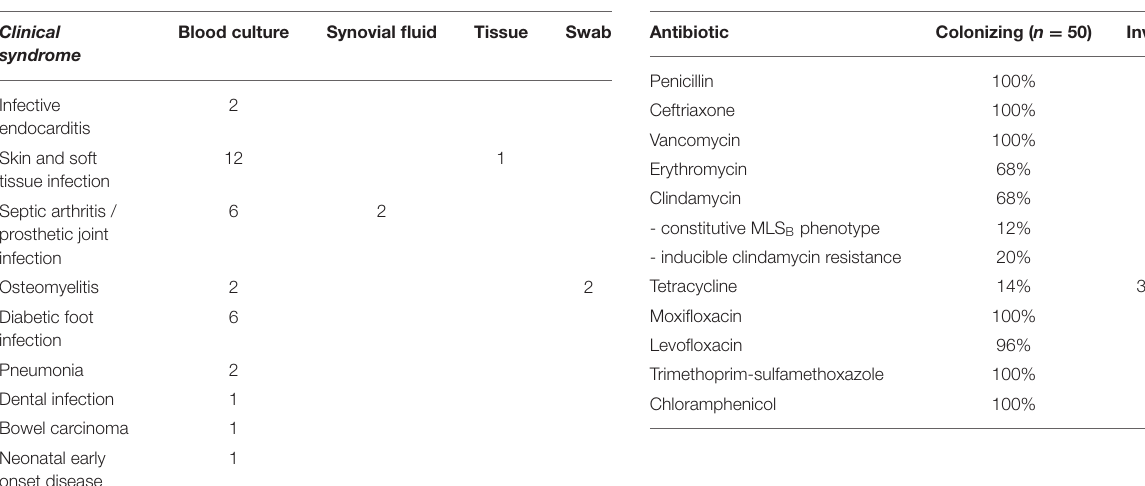
TABLE 3 | Specimen types for invasive GBS isolates included in the study ( n = 50).